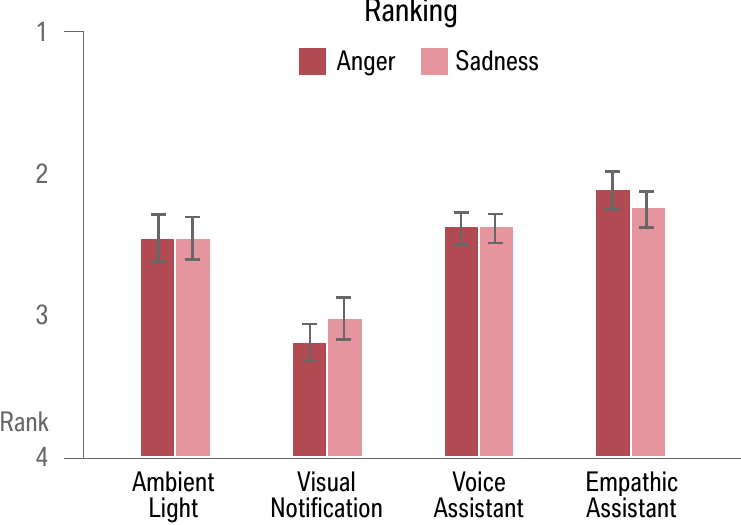
Figure 9. Rankings after the experiment. Participants assessed the concept Visual Notification as least desirable while Empathic Assistant is ranked best by a small